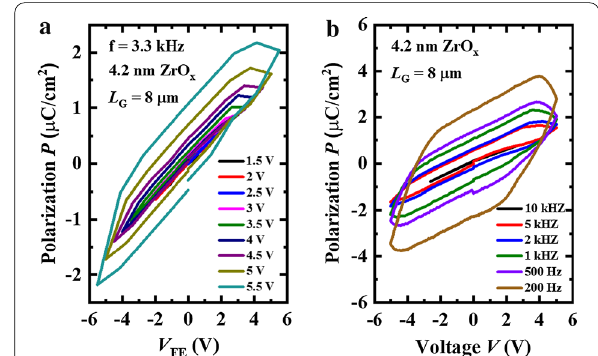
Fig. 2 Measured P versus V characteristics of the 4.2 nm ZrO x capacitors with a different sweeping ranges of V and b different measurement